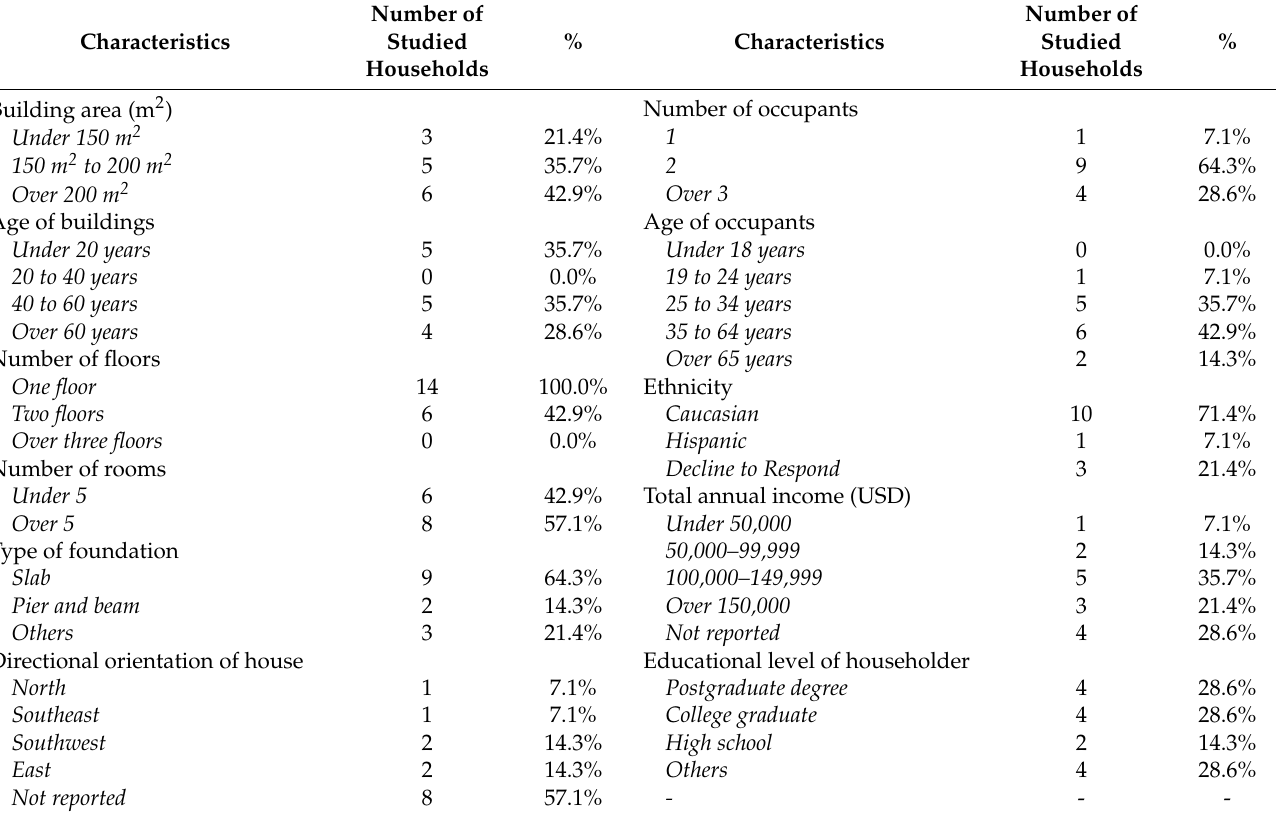
Table 2. The characteristics of selected residential buildings